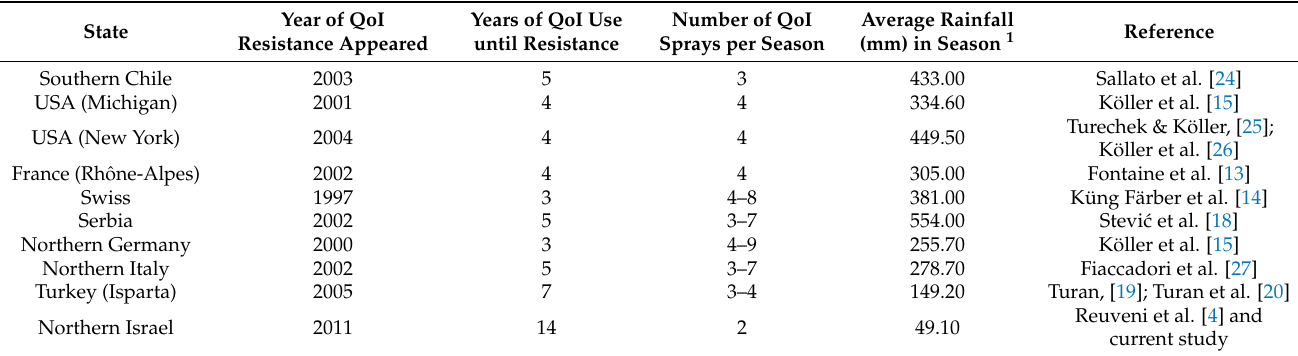
Table 3. Comparison of years of QoI fungicides use until resistance appearance, number of QoI sprays per season and average rainfall (mm) in the sensitive phenological stages, in different countries.